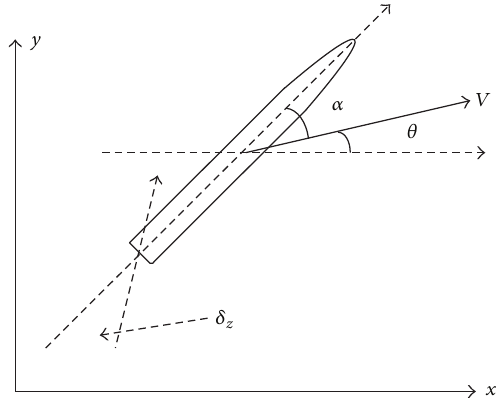
Figure 2: Air-frame